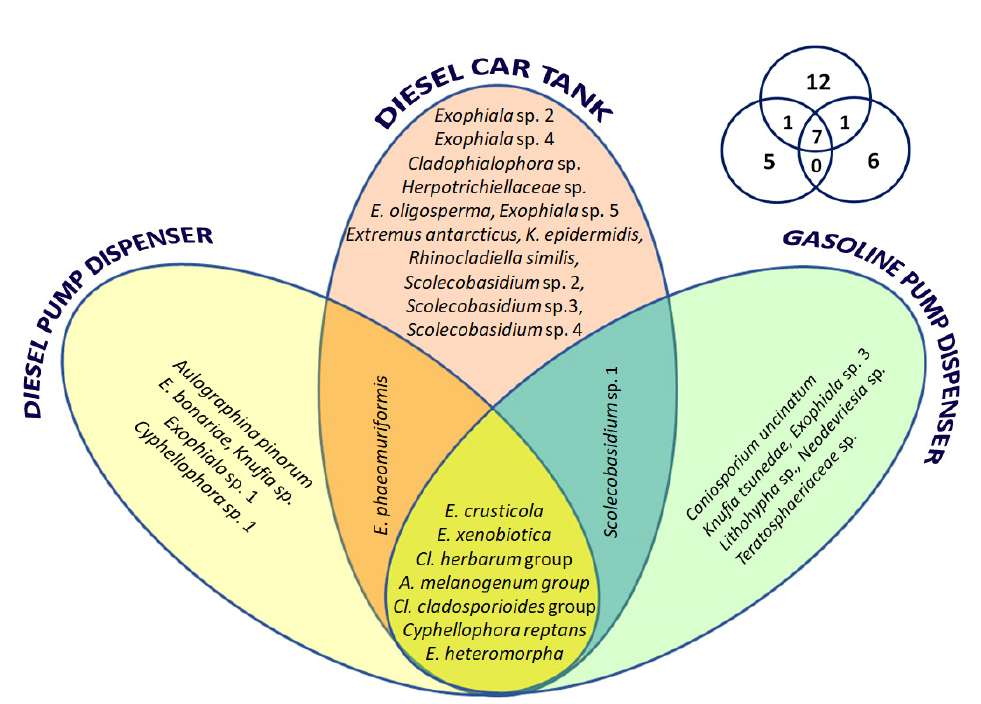
Figure 6. Venn diagram showing the presence of culturable black fungal species detected in diesel car tanks (DCT), diesel pump dispensers (DPD), and gasoline pump dispensers (GPD). On the upper right side, the Venn diagram of species richness is shown.